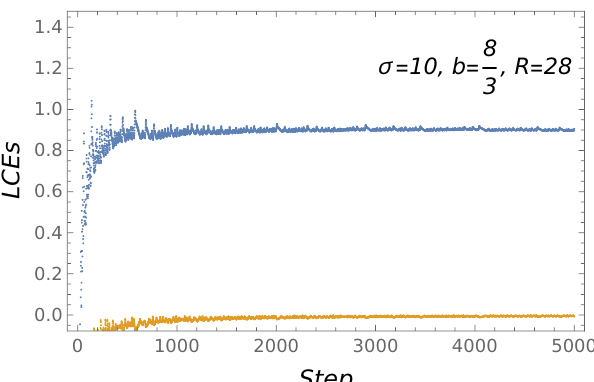
Figure 13 . Plot of the two largest LCEs for the Lorenz model. The initial conditions are x (0) = 29 , y (0) = 2 , z (0) = 20 . The total evolution time is T = 400 which is broken into 5000 iterative